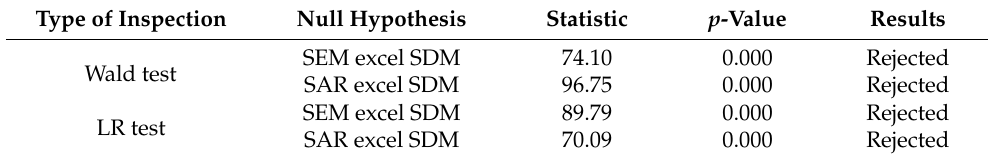
Table 2. Tests of Wald and LR.